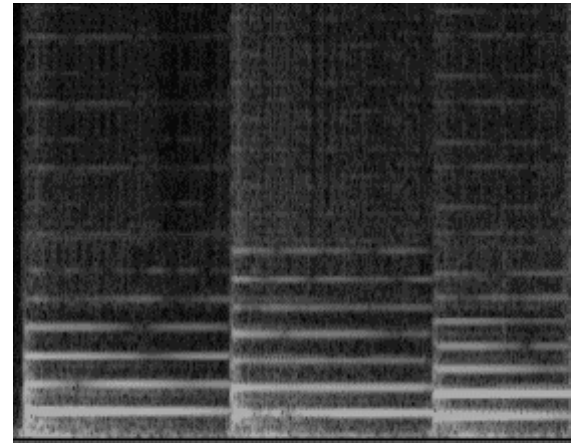
Figure 20. The spectrogram of the signal restored by three components. Appl. Sci. 2018 , 8 , x FOR PEER REVIEW